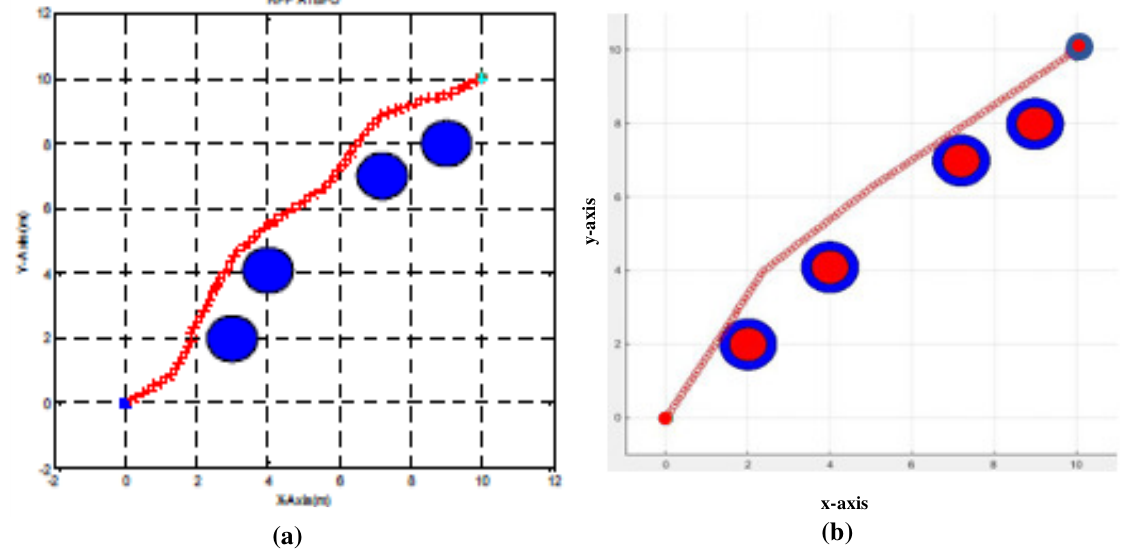
Fig. (19, (a)-(b)). The Best Results Achieved by (a) Reference [17], and (b)